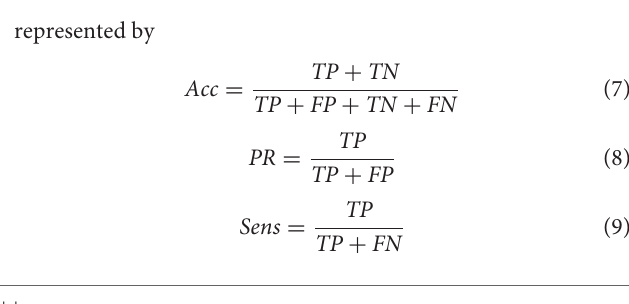
TABLE 7 | Five-fold CV results performed on the yeast dataset by the proposed model. Testing